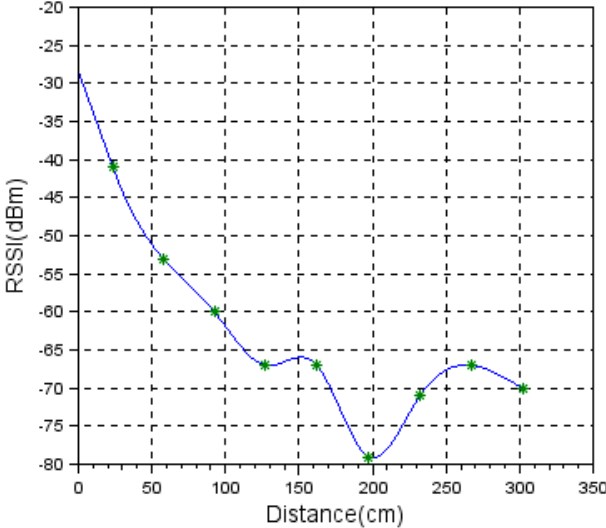
Figure 27. RSSI level vs. node orientation in a face-to-face vertical measurement setup.